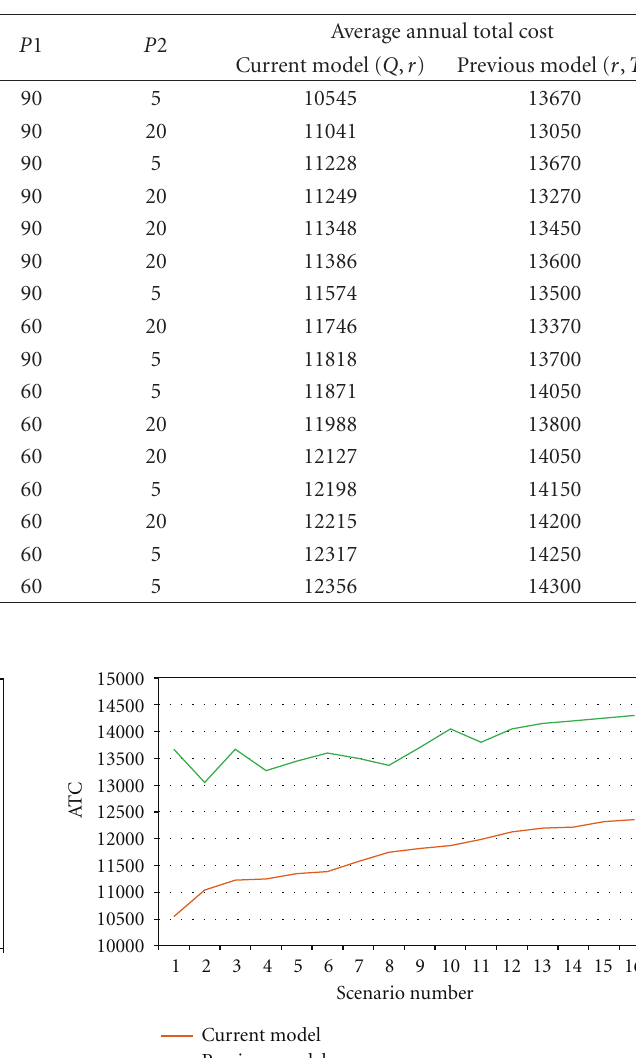
Table 5: Compare current model with previous study under impact of customer di ff erentiation on the inventory system.